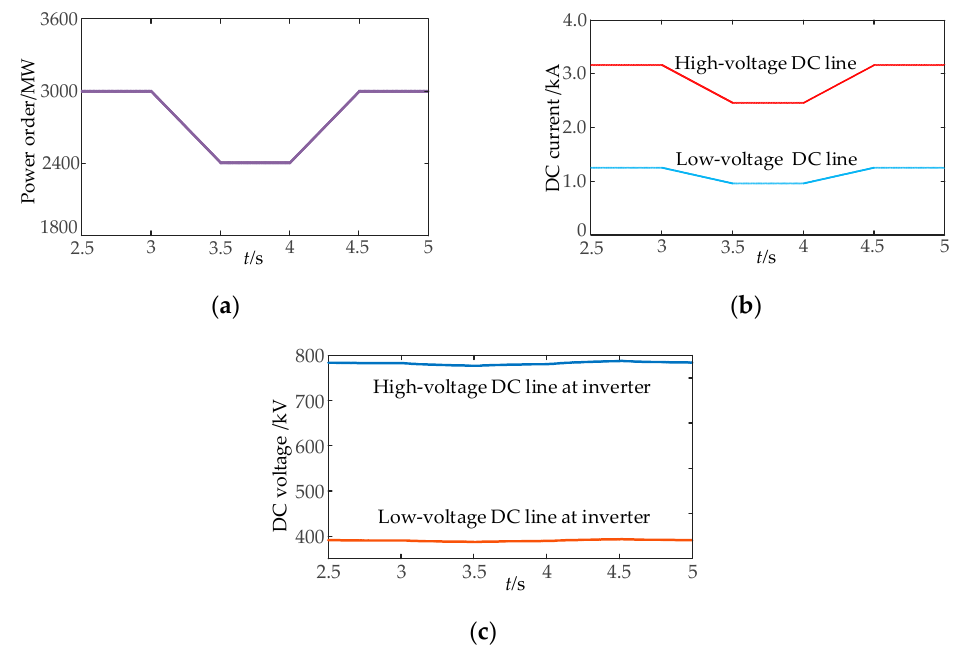
Figure 12. Response under system power command. ( a ) Power command of system. ( b ) DC current of transmission line. ( c ) DC voltage of system at the inverter side.